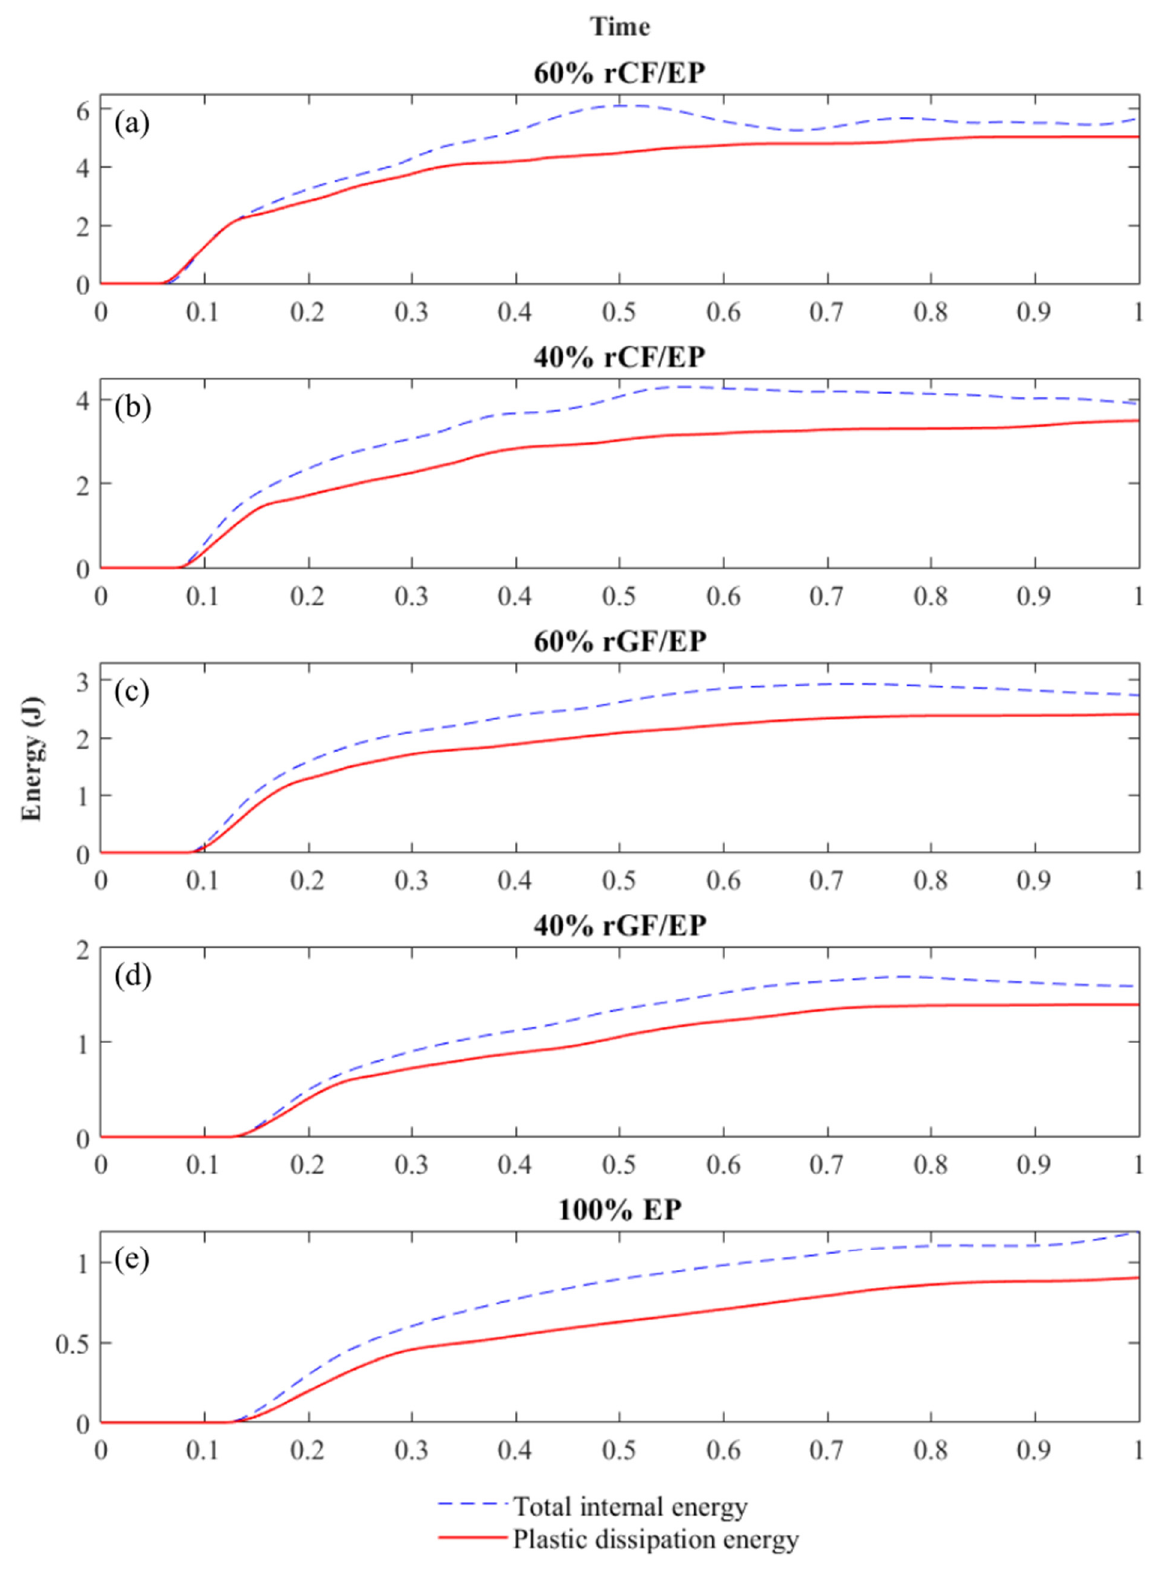
Figure 13. Internal energy observed by the composites after numerical IT: ( a ) 60% rCF/EP; ( b ) 40% rCF/EP; ( c ) 60% rGF/EP; ( d ) 40% rGF/EP; ( e ) 100% EP.